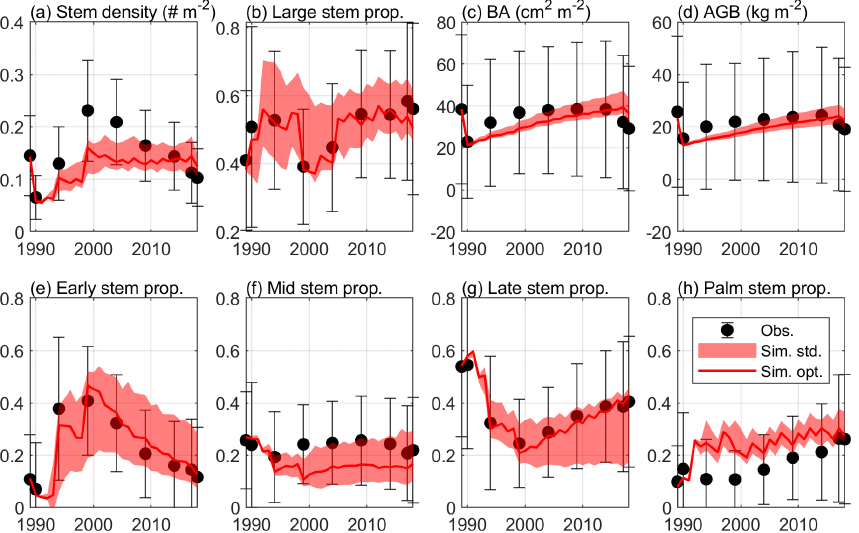
Figure 5. The standard deviation of the estimated variables with K = 8 in Eq. (4), along with the optimal simulation and observation. The figure shows (a) stem density of all stems with DBH ≥ 2 . 5cm (individualsm − 2 ), (b) stem density proportion of large stems with DBH ≥ 10cm, (c) basal area (BA; cm 2 m − 2 ), (d) aboveground biomass (AGB; kgCm − 2 ), and stem density proportion of (e) Early, (f) Mid, (g) Late, and (h) Palm